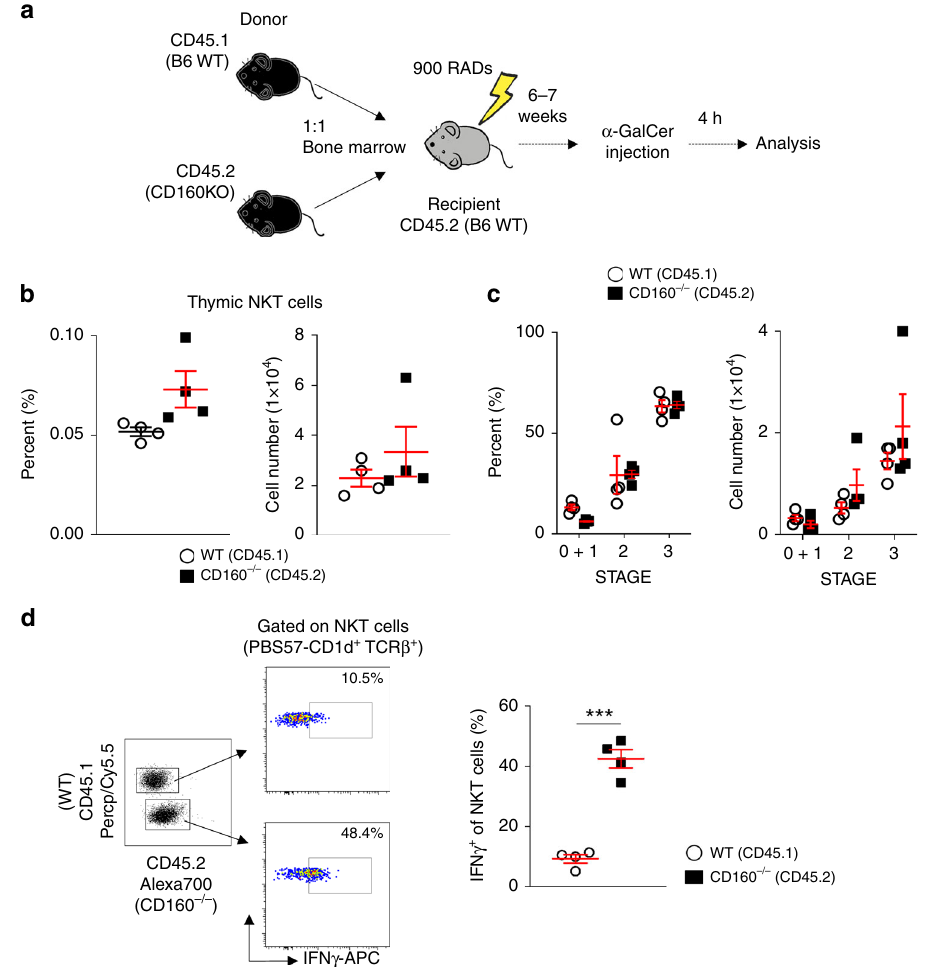
Fig. 6 CD160 − / − NKT cells show intrinsic defects during acute hepatitis. a Mixed bone marrow (BM) chimera mice were generated using a 1:1 ratio of WT (CD45.1) and CD160 − / − (CD45.2) BM cells for transfer into WT hosts; 6 – 7 weeks later, mice were injected with 2 μ g of α -GalCer for 4 h. b - c Thymic NKT cells were analyzed by multiparametric fl ow cytometry using TCR β , CD1d-tetramer, CD44, NK1.1, CD45.1, and CD45.2 to identify NKT cells in mixed BM chimera mice ( n = 4 per each group). d Representative FACS plots of IFN- γ in NKT cells following in vivo challenge with 2 μ g of α -GalCer. All data represent the mean ± S.E.M. Results are representative of two independent experiments ( n = 4 per group). * P < 0.05, ** P < 0.01, *** P < 0.001 with a paired T